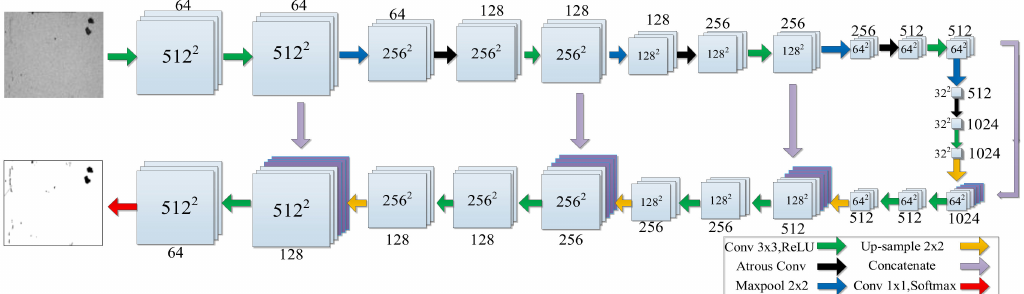
Figure 3. The architecture of the autoencoder (AE) network.